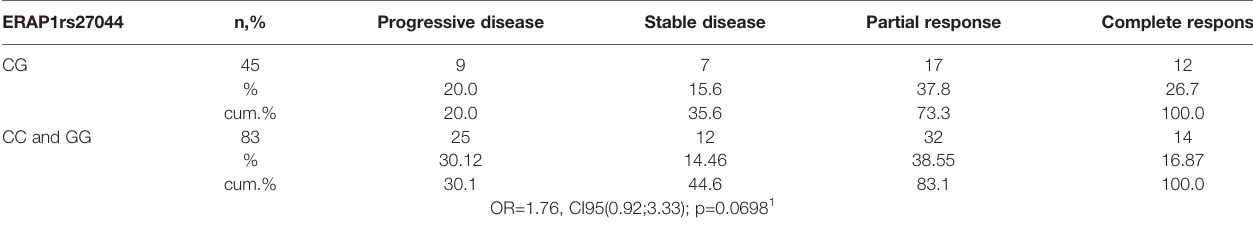
TABLE 7 | Response to chemotherapy depending on ERAP1 rs27044 polymorphism and adjusted by clinical characteristics listed below.